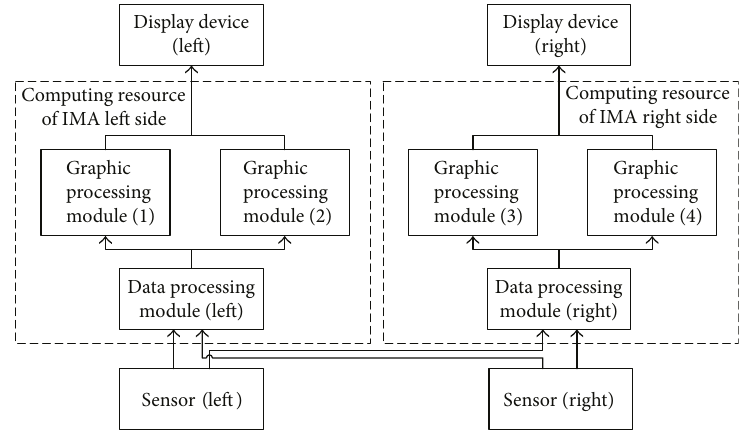
Figure 14: Architecture of bilateral tolerant display function.